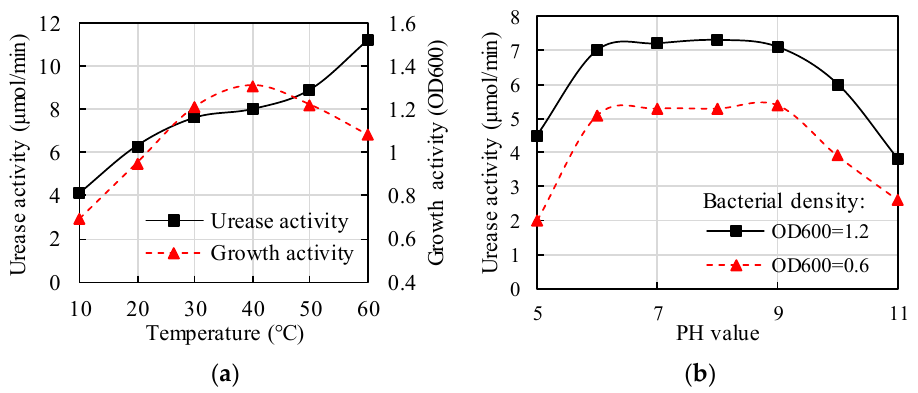
Figure 2. Changes of urease activity influenced by ( a ) Temperature ( b ) PH value.